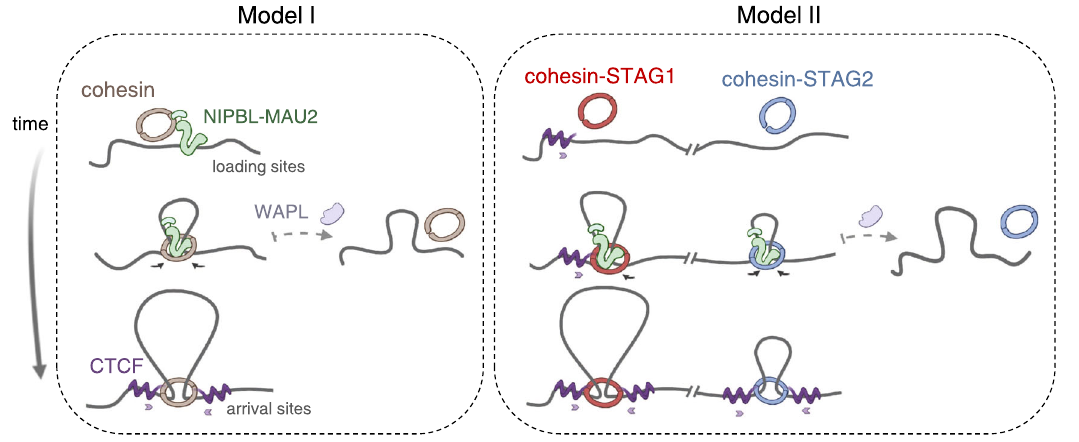
Fig.6|AnalternativemodelfortheroleofNIPBLinchromatinassociationand extrusion by the two cohesin variants. In model I, NIPBL-MAU2 promotes chro- matin association of cohesin (STAG1 or STAG2) as well as loop extrusion until the complex is released by WAPL or becomes arrested by CTCF proteins bound in